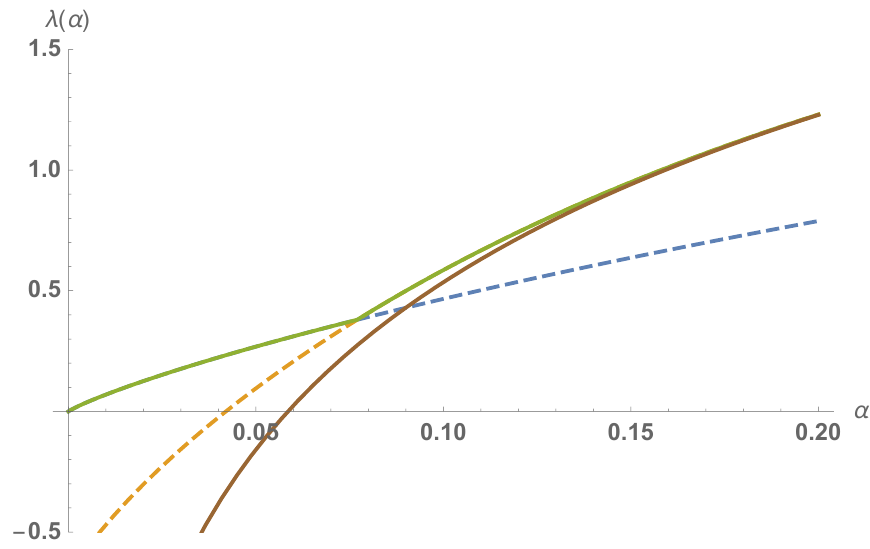
Figure 2 . Density of primary states of averaged code theory. Dashed blue and orange lines: λ 1 and λ 2 correspondingly. Green line: λ = max( λ 1 , λ 2 ) . Brown line: Cardy formula λ C = ln(2 π e α )